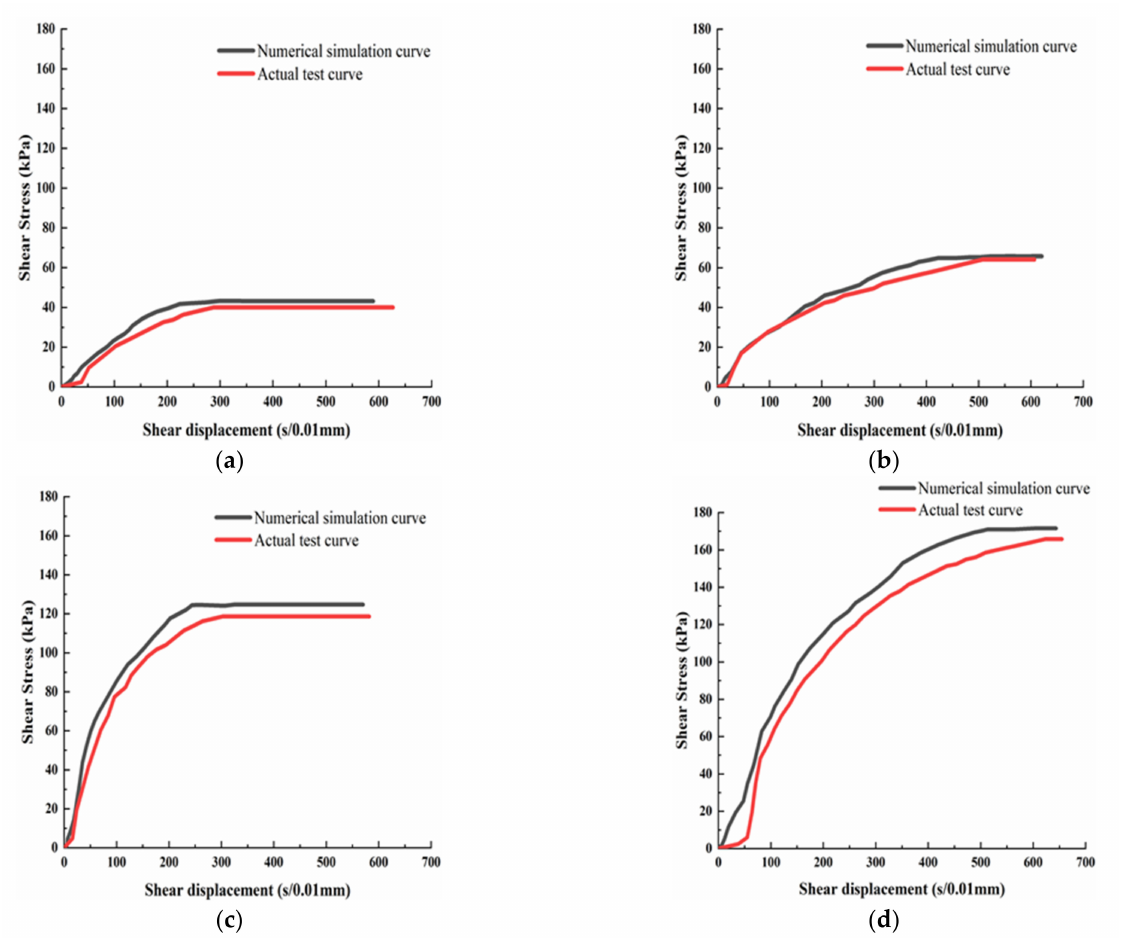
Figure 13. The shear stress-displacement contrast curves: ( a ) 50 kPa; ( b ) 100 kPa; ( c ) 200 kPa; and ( d ) 300